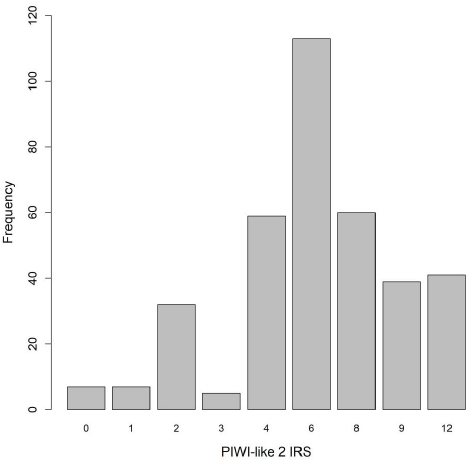
Figure 2. Distribution of PIWI-like 2 IRS in invasive breast cancer. Cancers 2020 , 12 ,